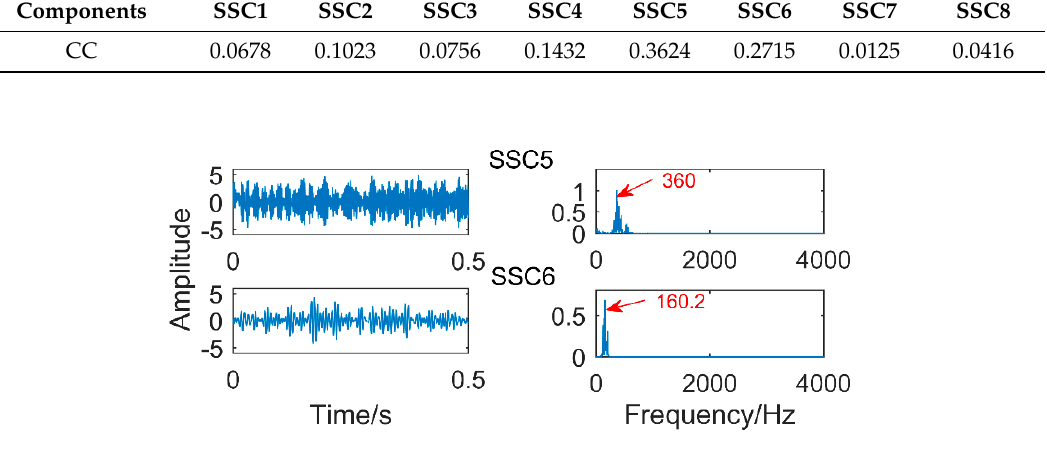
Figure 33. The result obtained by the proposed method.